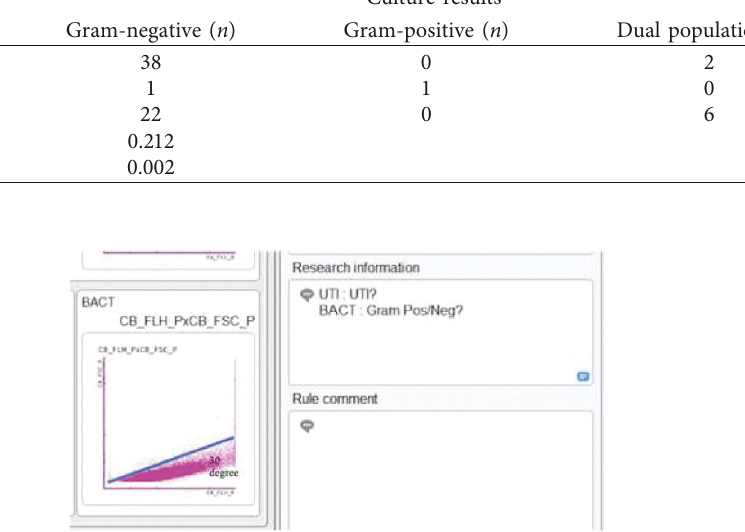
Figure 5: Adjusted dominant angle ( < 30 ° was determined as Gram-negative, and ≥ 30 ° was determined as Table 5: Agreement between angle determination and the urine culture result.